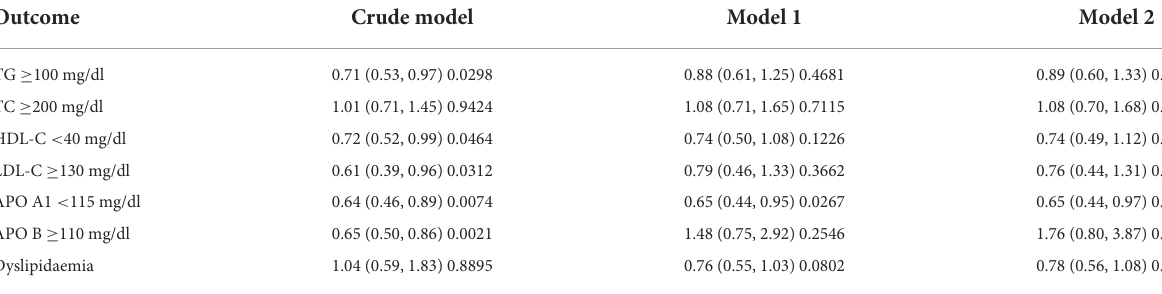
TABLE 3 Multivariable logistic regression between serum zinc and dyslipidaemia.